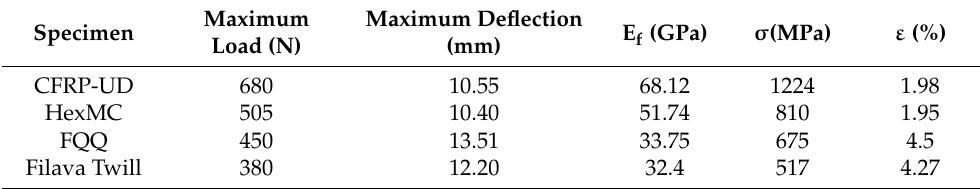
Figure 12. Flexural plot of all four samples according to BS-ISO:14125. Table 6. Flexural properties and elongation of all samples